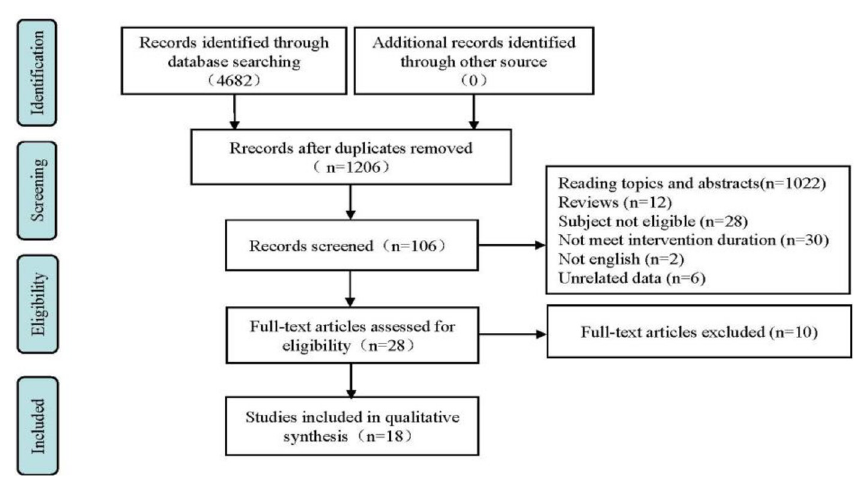
Fig 1. PRISMA flow chart of study selection